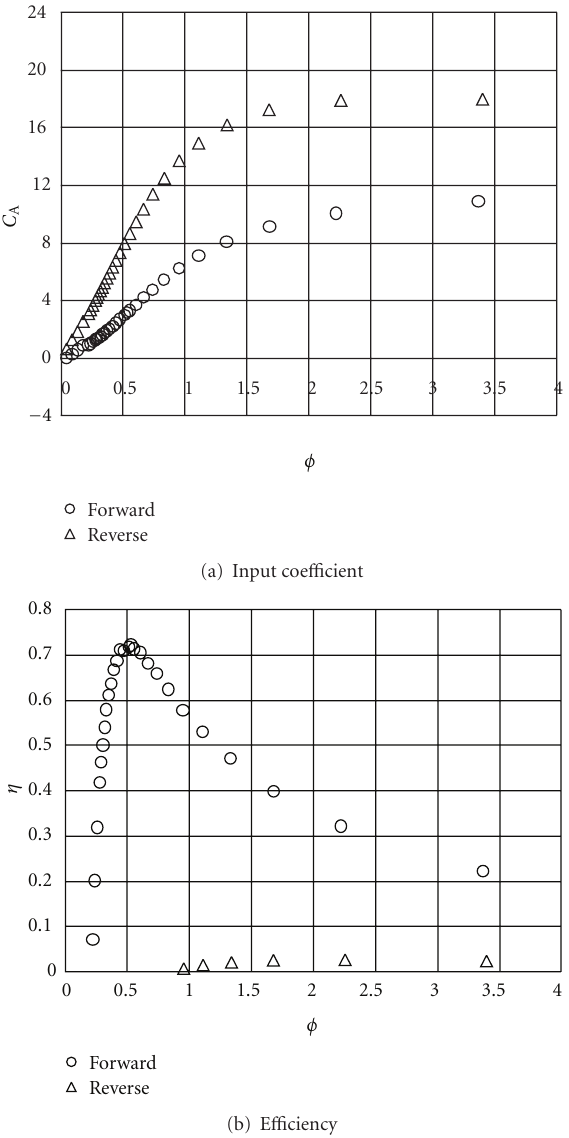
Figure 21: E ff ects of flow direction on turbine characteristics